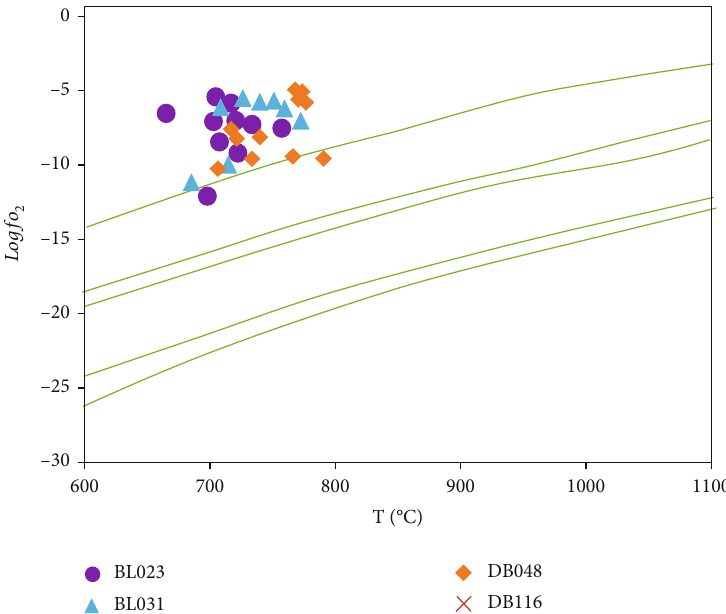
Figure 6: Physical and chemical oxygen fugacity log(fo